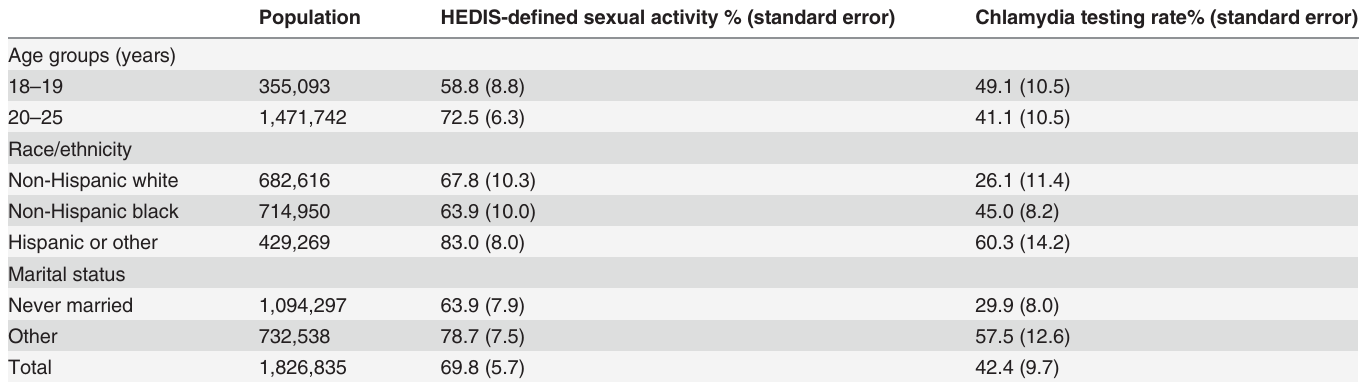
Table 3. HEDIS-defined sexual activity and chlamydia testing rates among women aged 18 – 25 years who were eligible for the HEDIS measure (N = 172), 2001 –